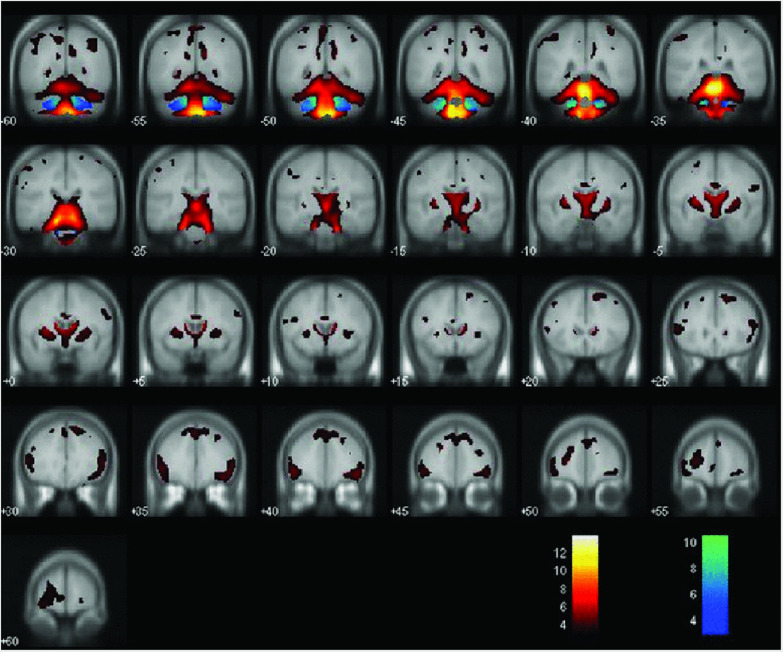
Areas of decreased gray matter density (hot colors) and white matter density (cold colors) when comparing MJD/SCA3 and controls (P < 0.001). Reprinted with permission from Wiley (D’Abreu et al., 2012).